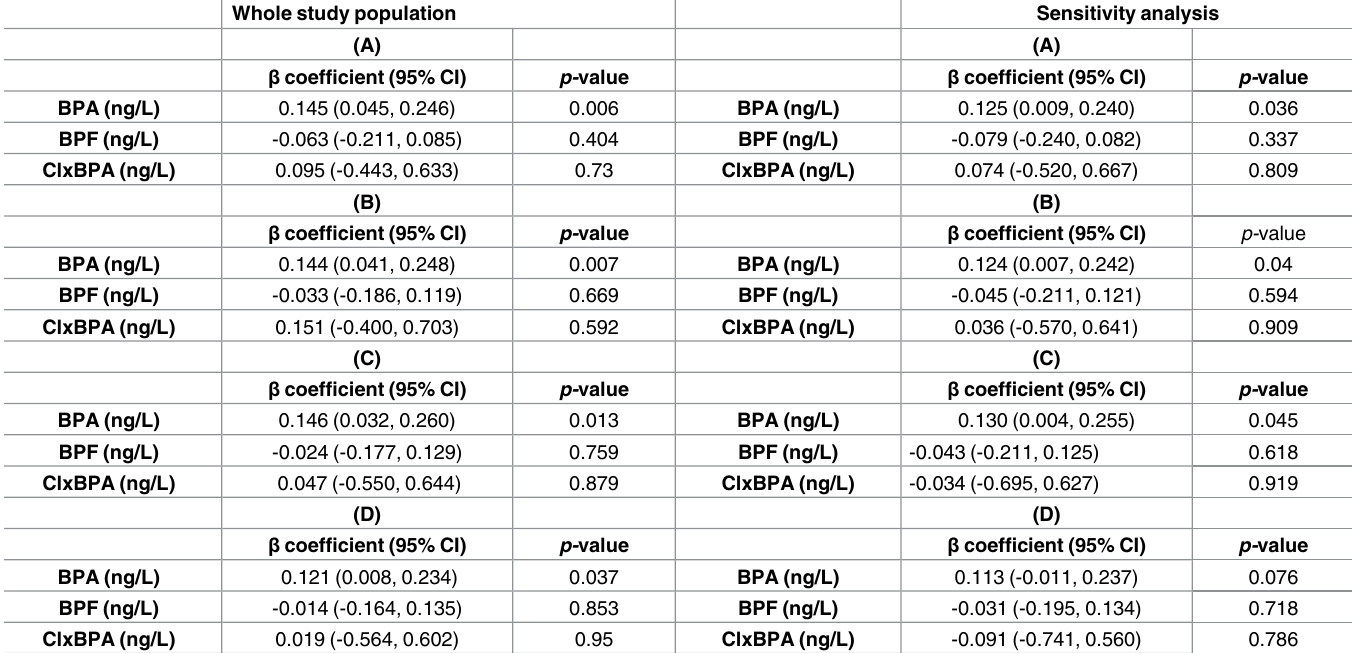
Table 4. Test for trend in multivariate models adjusted for age, BMI, study site and disease status (creatinine adjustment has been included in all models) for the whole study population and including only those between the 5 th and 95 th percentile of BPA, BPF and ClxBPA (ng/L) urinary